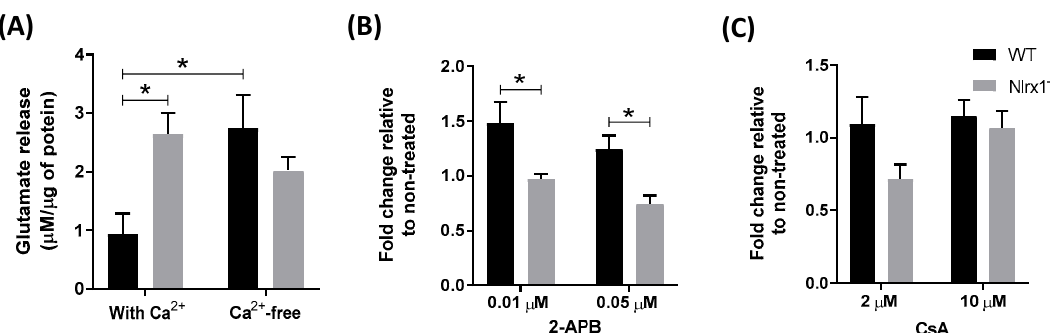
Figure 2. Excess Ca 2 + release from the ER mediates glutamate release from Nlrx1 - / - astrocytes. ( A ) WT and Nlrx1 - / - astrocytes were incubated in a Ca 2 + -containing HBSS bu ff er or Ca 2 + -free Lock’s solution for 1 h ( n = 7); ( B ) astrocyte cultures were incubated with 0.01 or 0.05 µ M of 2-APB ( n = 5), or ( C ) with 2 or 10 µ M of CsA ( n = 6) in the Ca 2 + -free Lock’s solution for 1 h. The supernatant was collected from all cultures and glutamate in the medium was measured by the glutamate assay kit. * p < 0.05 as determined by Tukey’s test, results are presented as mean ± SEM.